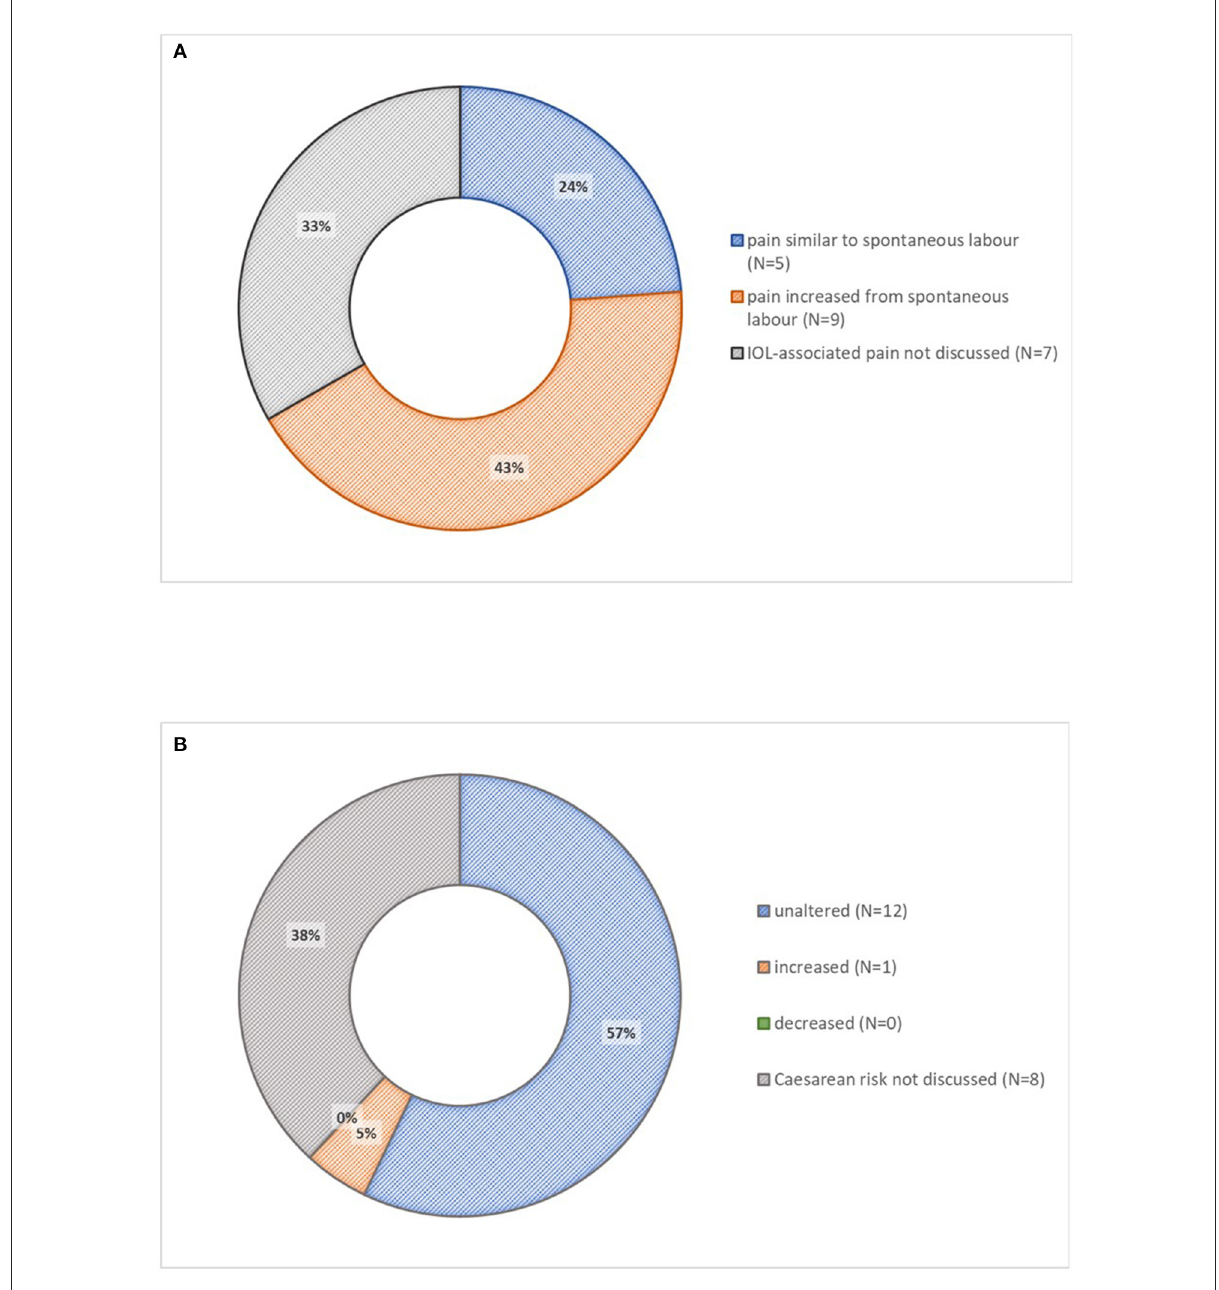
FIGURE4 Described harms of induction of labor in 21 patient information leaflets. (A) Induction-associated pain. (B) Risk of Cesarean delivery. IOL, induction of